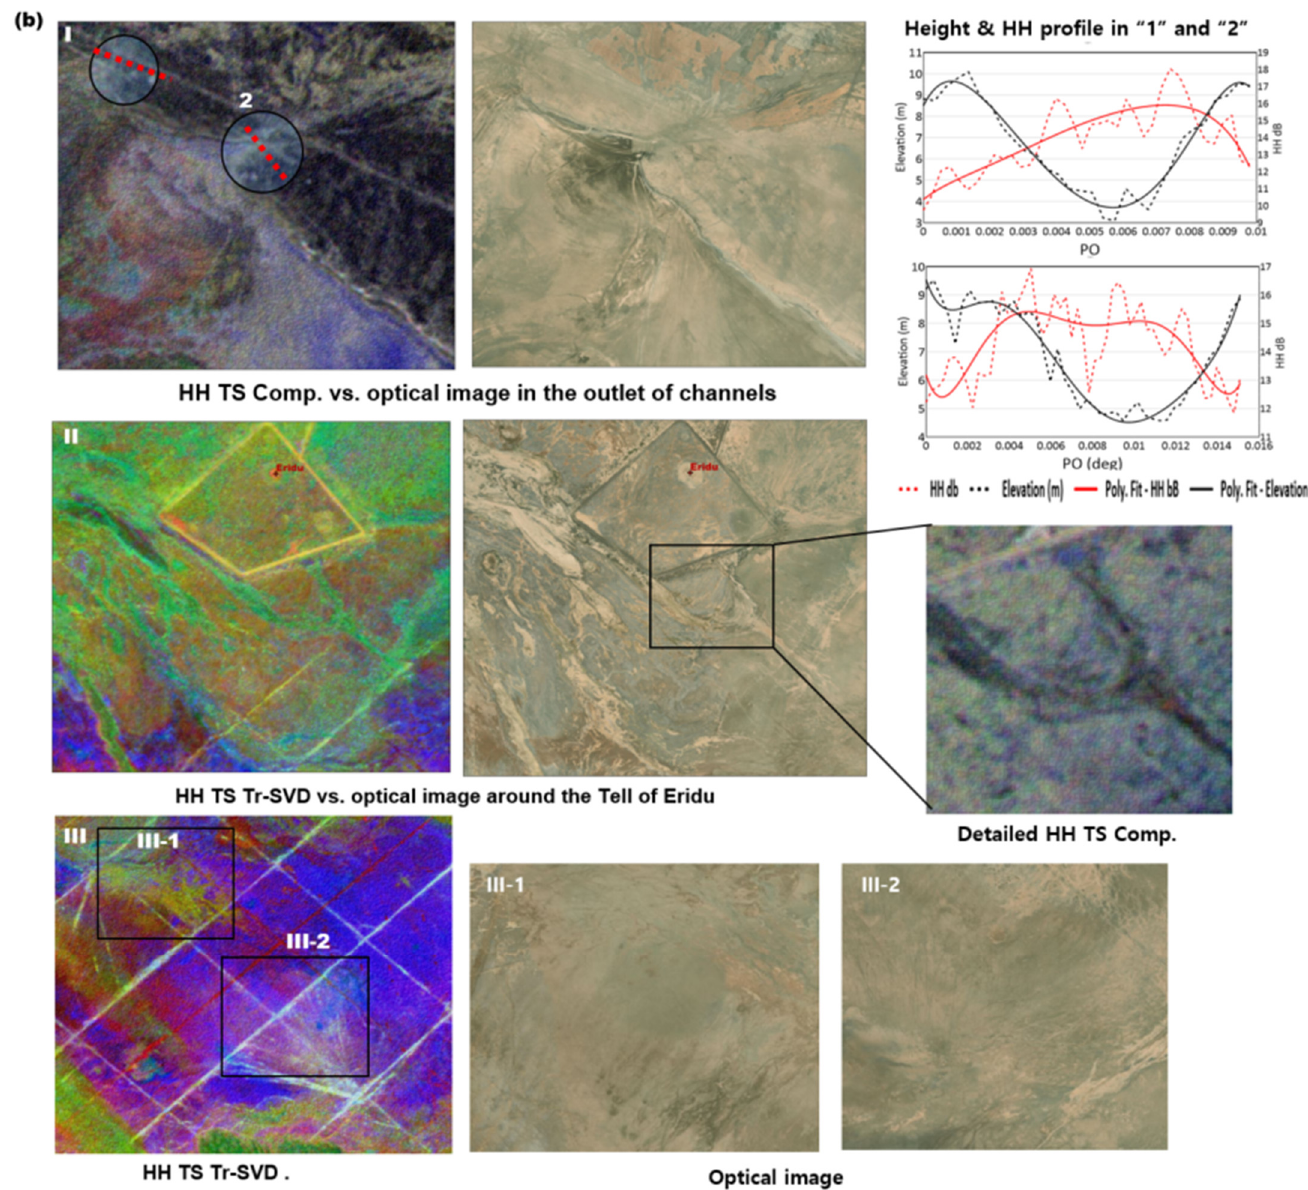
Figure 9. ( a ) InSAR Comp. in ROI-3 overlaid with ancient channels, which implied extensive dissection by Sumerian age’s rivers and wetland environments. ( b ) The details of ROI-3 of SAR Comps. compared to optical images showing the outlets of the channel networks (I), avulsion of channels around the Tell of Eridu, and (II) intersection/spoke-style trails in the southern part of Eridu (III). Figure 9b demonstrates the notable parts of ROI-3 presented in the HH TS Comp.